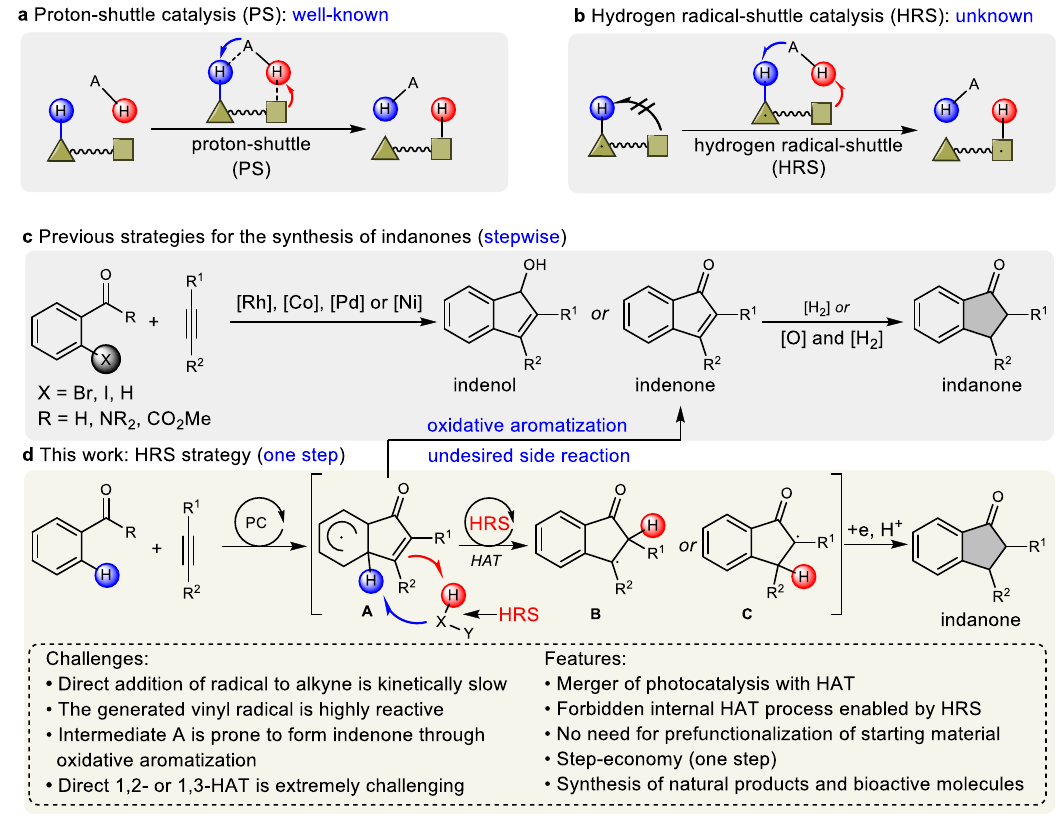
Fig. 1 Proton/hydrogen radical-shuttle catalysis and indanone scaffold synthetic strategy. a Proton-shuttle catalysis model. b Hydrogen radical-shuttle catalysis model. c Traditional synthetic strategies for indanones by annulation reaction of alkynes. d HRS-enabled strategy for indanone synthesis (this work). PC